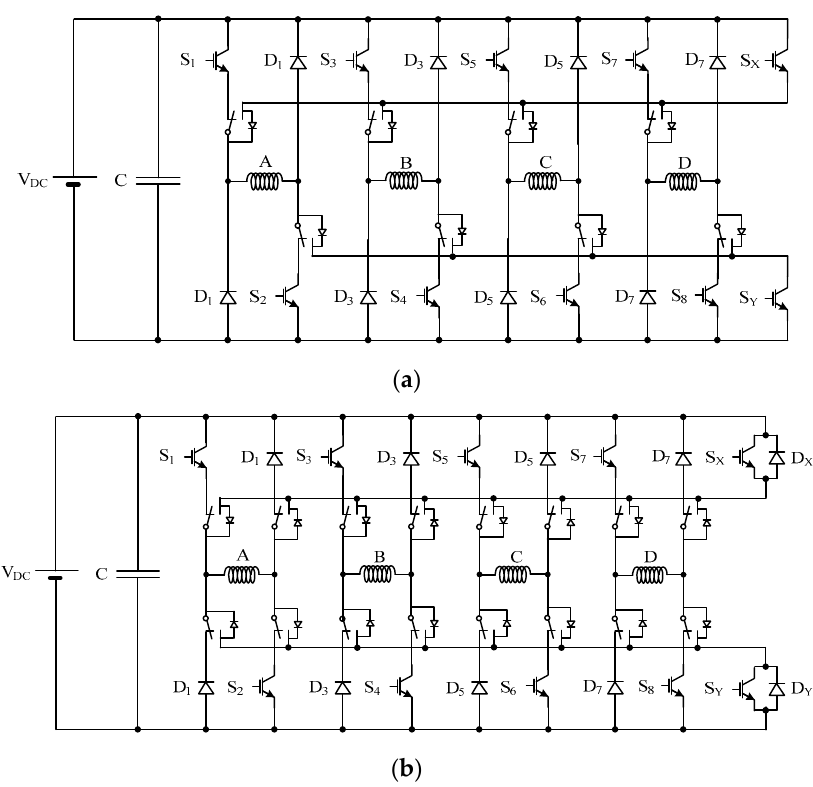
Figure 23. Fault-tolerant topologies proposed by [88]. Solution for isolate and replace the faulty controlled power semiconductor ( a ) and faulty controlled power semiconductor and freewheeling diode simultaneously ( b ).